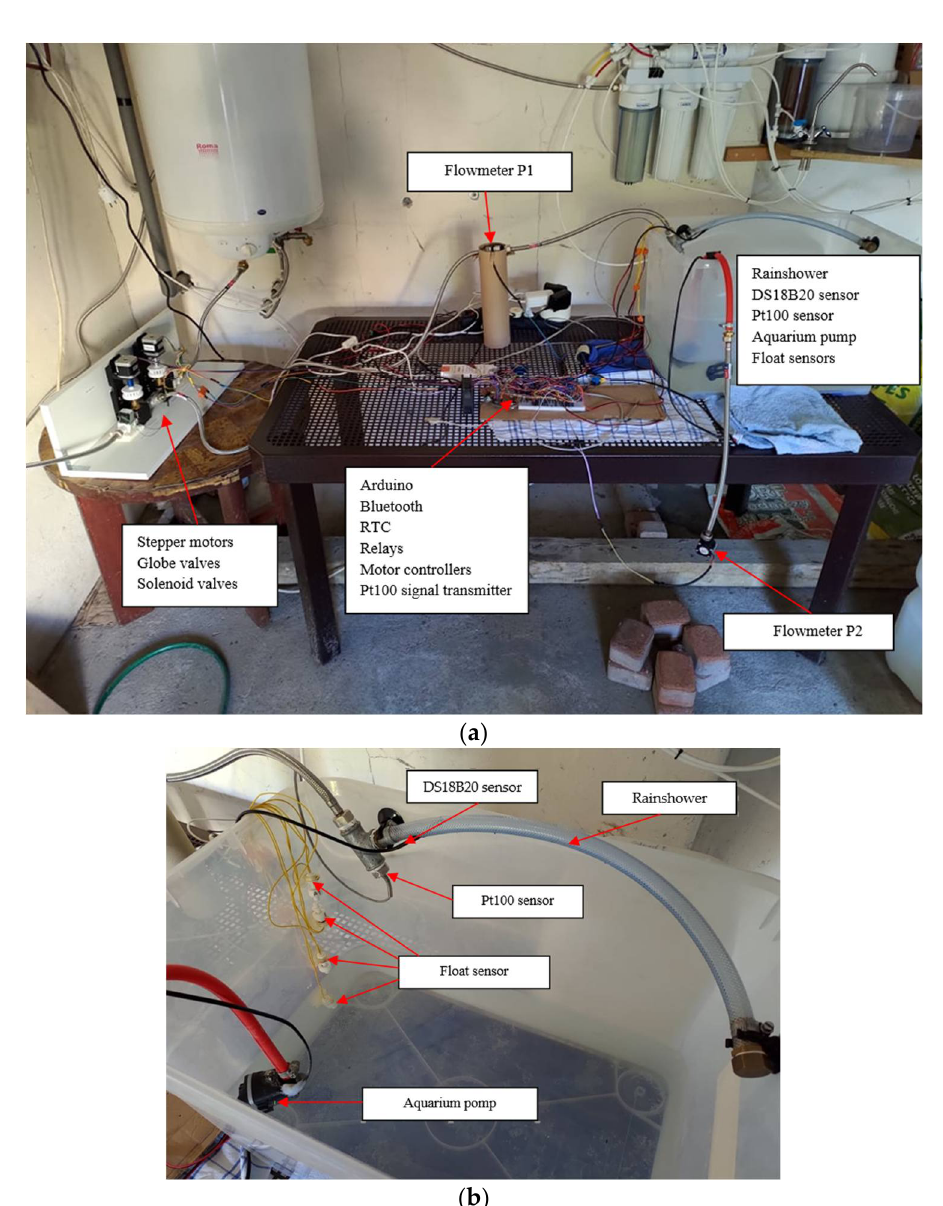
Figure 5. Test stand for the AWES ( a ); container representing an aquarium and sensors responsible for measuring the current level of the liquid and temperature ( b ). Table 5. List of components used for the AWES prototype. The additional parts of the AWES system, such as a knob, a cap, clutches, or handles, are not detailed